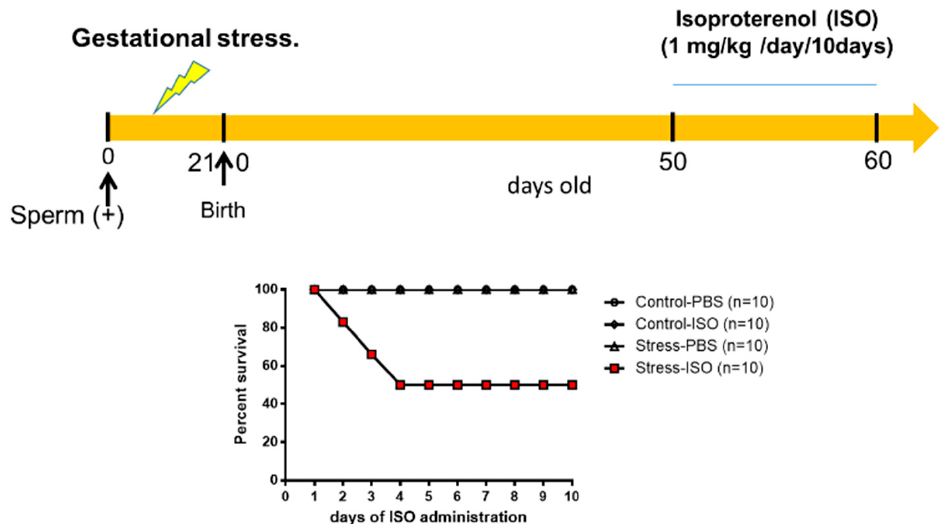
Figure 6. Gestational stress increased the cardiac sensitivity of the male progeny to adrenergic overload. Rats were treated with daily doses of 1 mg/kg weight isoproterenol or saline for control or stressed rats. The graph reflects the percentage of survival of young adult rats after their corresponding treatments. The results correspond to the mean ± mean standard error. Each group consists of 10 animals.